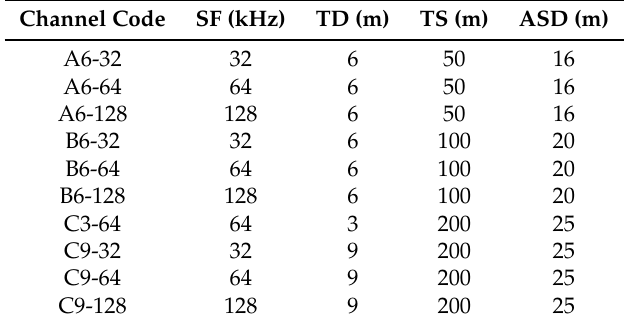
Table 1. Summary of measured channel characteristics. SF: Sounding signal frequency, TD: Transducers’ depth; TS: Transducers’ separation; ASD: Average sea depth.